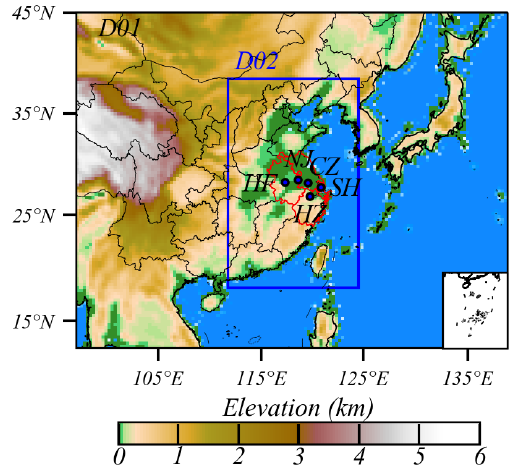
Figure 1. The entire YRD region as the target region (marked as red) in two nested simulation domains (36 and 12km resolutions) and the location of five representative YRD cities used in modeling evaluations in the d02 modeling domain. Publisher’s note: please note that the above figure contains disputed